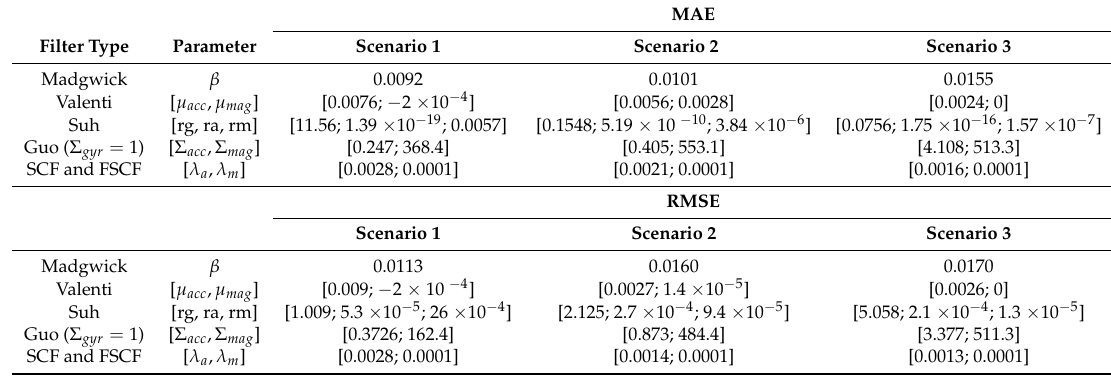
Table A1. Review of optimizes parameters for all tested filters, optimization criteria (the mean absolute error (MAE) and the root mean square error (RMSE)), and test